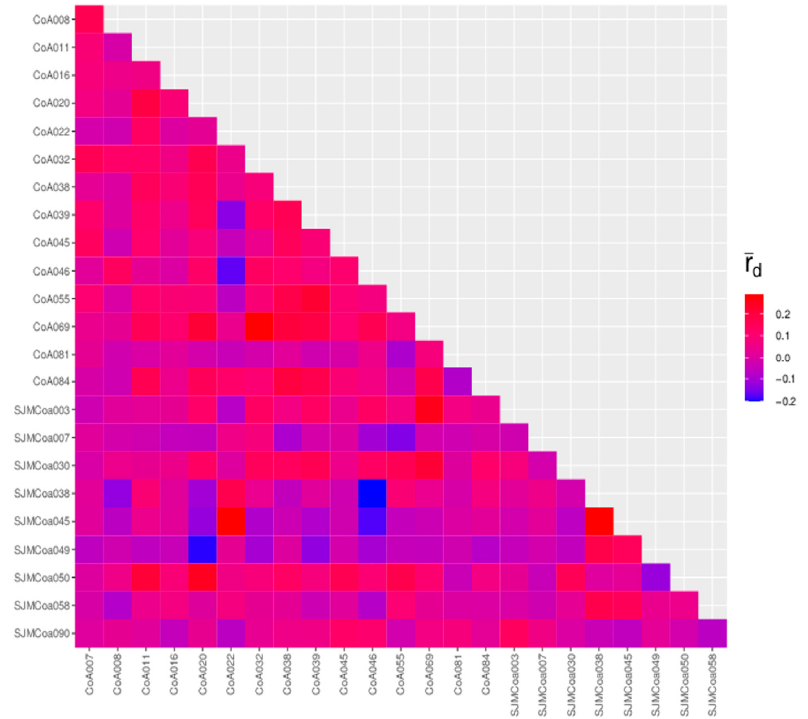
Figure 5. The linkage disequilibrium of 24 SSR loci.